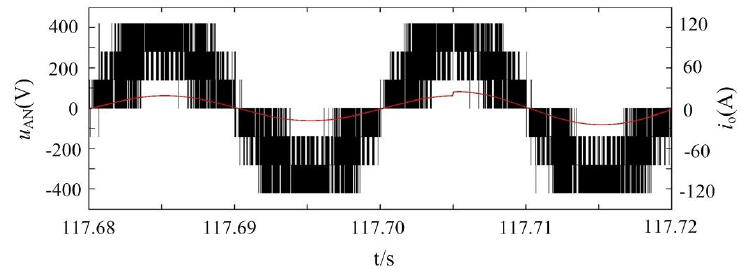
Figure 13. Voltage and current of A-phase